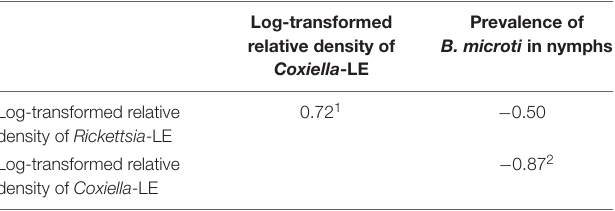
TABLE 5 | Bivariate correlation of parasitemia density of mice, body weight of engorged larvae, relative density of Coxiella - or Rickettsia -LE, and prevalence of B. microti in R. haemaphysaloides nymphs.